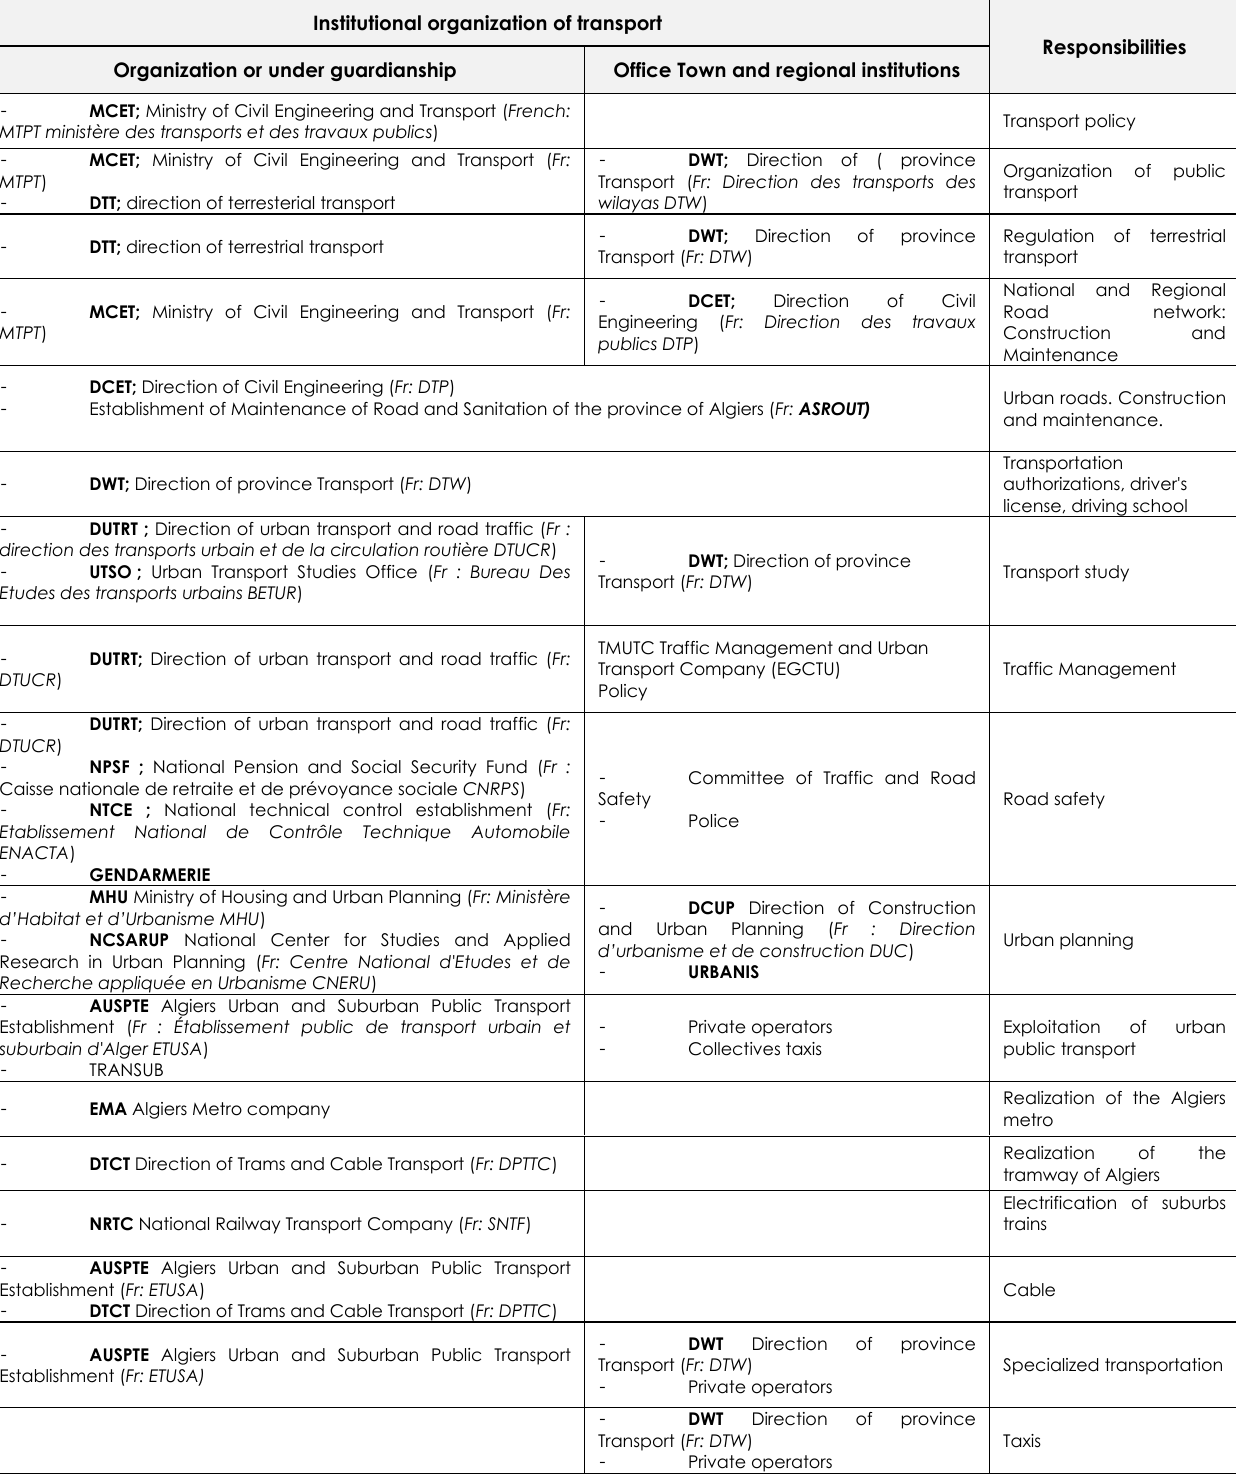
Table 2. Synthesis of transport organizations and these